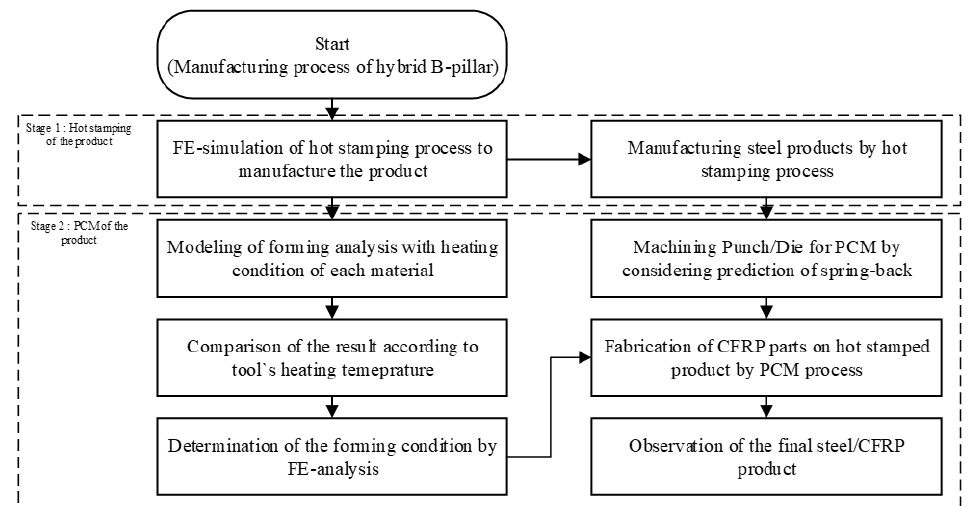
Figure 2. Procedure for the process design of the steel/CFRP B-pillar assembly.